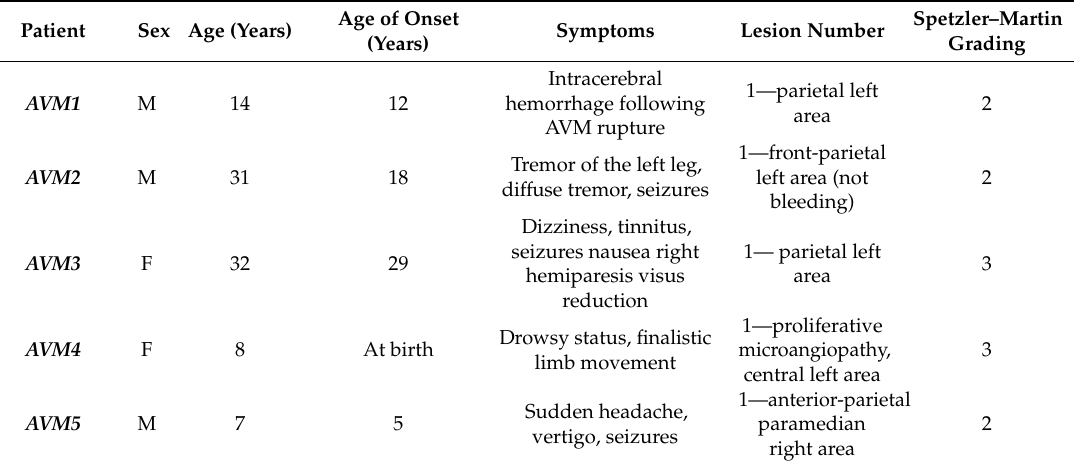
Table 4. Anamnesis data of the patients enrolled in the